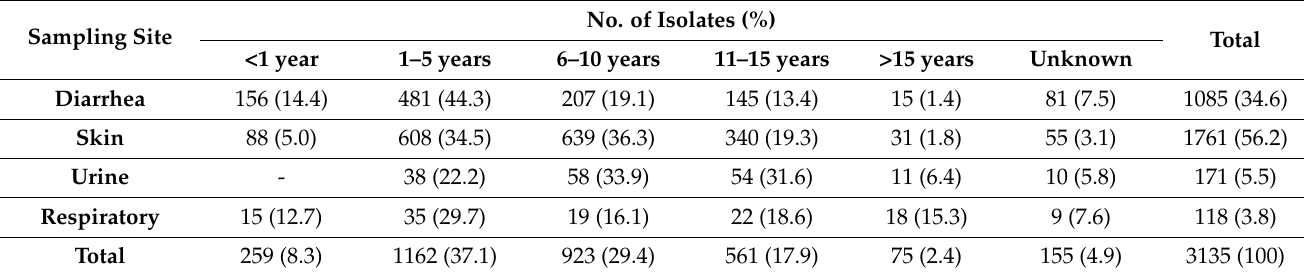
Table 1. Number of recovered isolates from four targeted samples and different age groups of dogs.